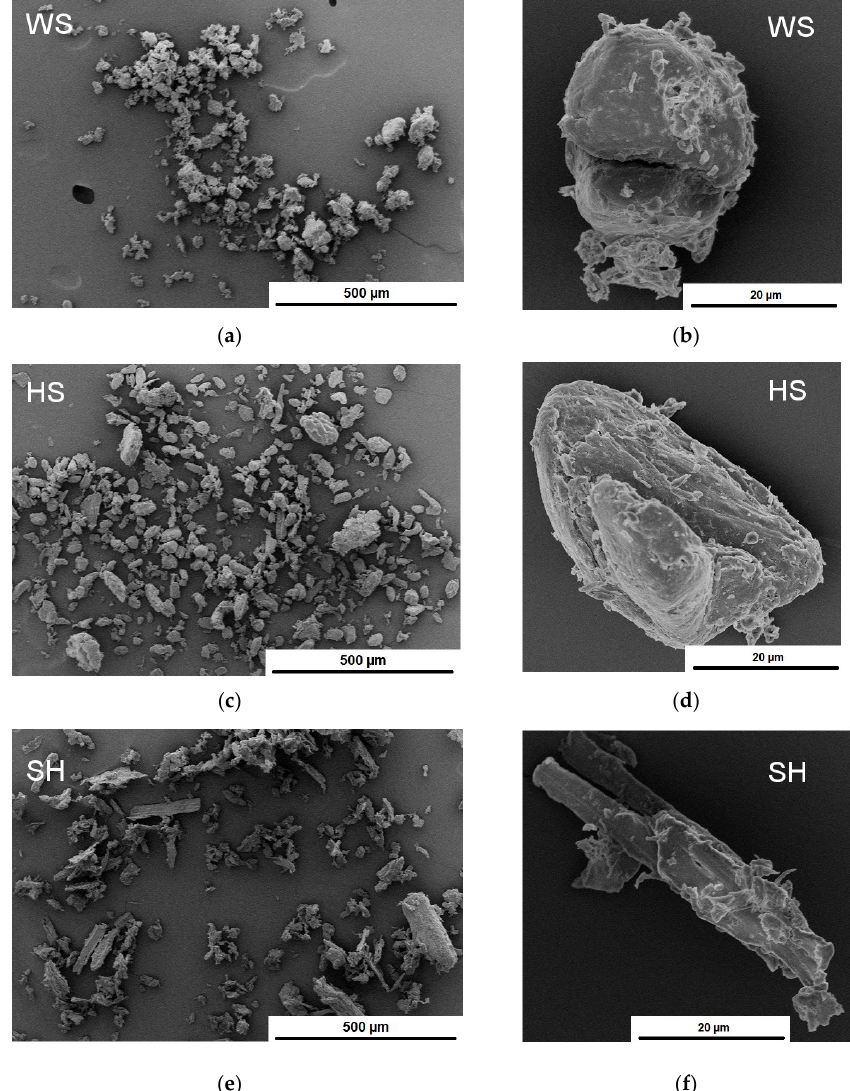
Figure 3. SEM images of ground WS ( a , b ), HS ( c , d ), and SH ( e , f ).